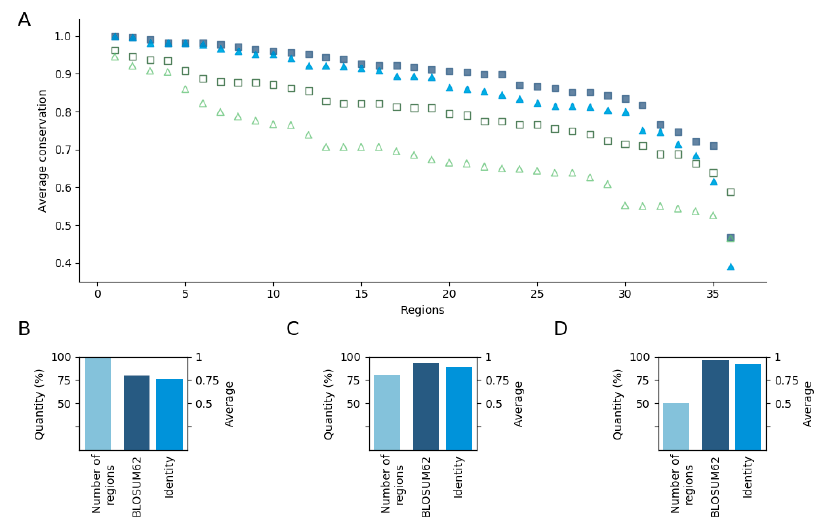
Figure 2. Representation of average conservation values. ( A ) Sorted conservation values for each region having positions with at least one mutation and for the whole protein. Squares (dark blue—region, green—whole sequence) and triangles (light blue—regions, green—full sequence) represent BLOSUM62 and identity based conservation values, respectively. The outlier at the very end of the sequence corresponds to the region of BCL2. ( B – D ) The number of regions and average conservation value of regions having positions with at least 1, 15, and 25 mutations, respectively. The conservation values are based on BLOSUM62 and identity, and the number of regions are colored by dark, medium, and sky blue, respectively.